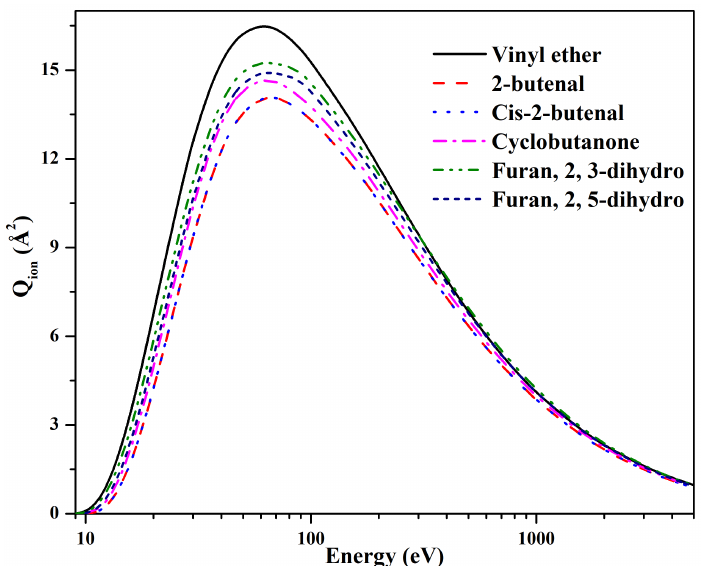
Figure 11. Q ion for vinyl ether and its isomers. Solid line: present Q ion for vinyl ether; dash line: present Q ion for 2-butenal; dotted line: present Q ion for cis-2-butenal; dash-dot line: present Q ion for cyclobutanone; dash-dot-dot line: present Q ion for furan, 2, 3-dihydro; short dash line: present Q ion for furan, 2,